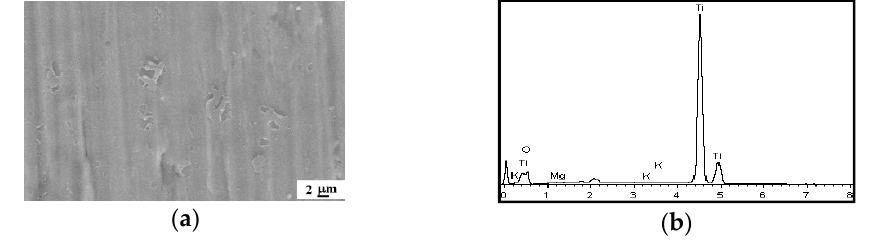
Figure 4. ( a ) The SEM image and ( b ) EDS spectrum of the MAO coatings produced in the solution of 10-g/L Na 2 MgY and 8-g/L KOH.